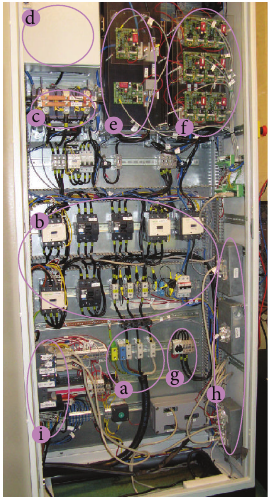
Figure 5: The electrical enclosure at the control station. Generator powercable(a),contactorsandfuses(b),dioderectifier(c),enclosed capacitors (d), load control IGBT’s (e), startup inverter (f), manually operated parking brake (g), voltage and current measurements (h), and CompactRIO